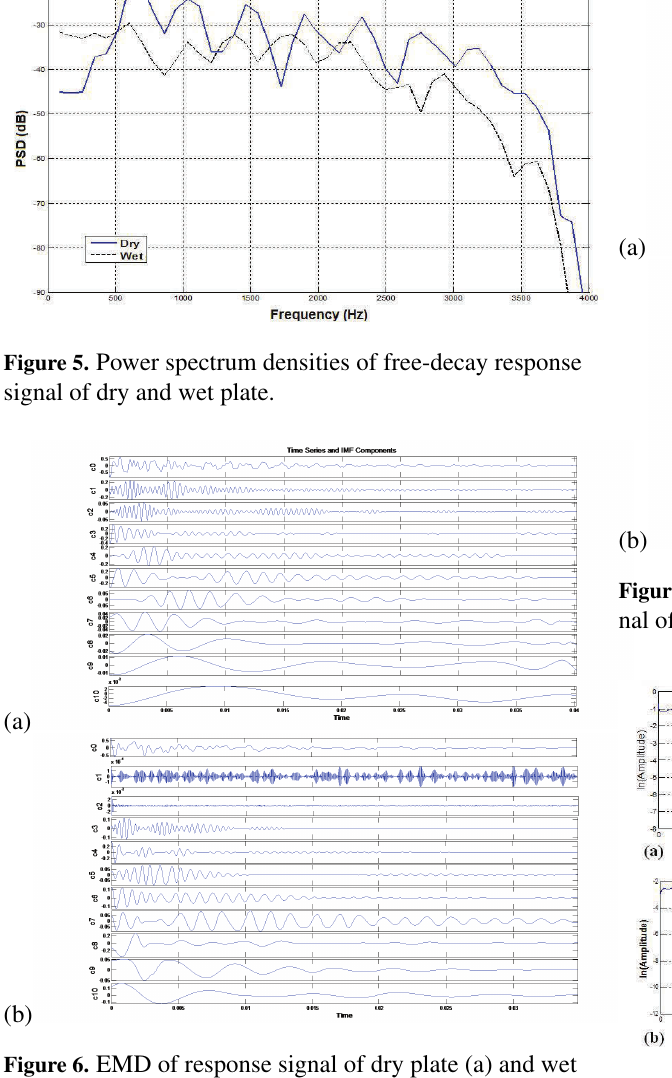
Figure 8. ln a ij of IMFs (corresponding to 1st mode in Ta- ble 1) of dry plate (a) and wet plate (b) as functions of